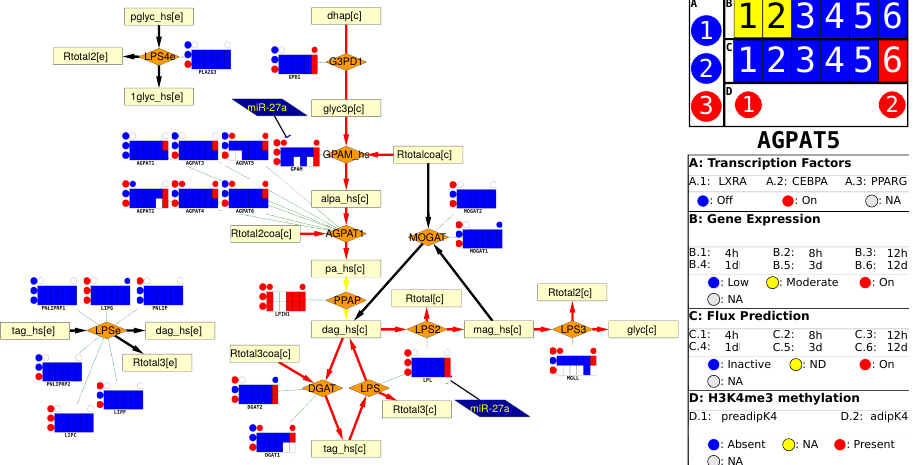
Figure 1. Data visualization of the tri-acyl glycerol synthesis pathway during differentiation of adipocytes. Activation of parts of the synthesis pathway at the end of the differentiation is easily visible. Reactions are represented as orange rhombus, metabolites by light yellow boxes and miRNAs as dark blue trapezoids. The metanode legend can be found on the right